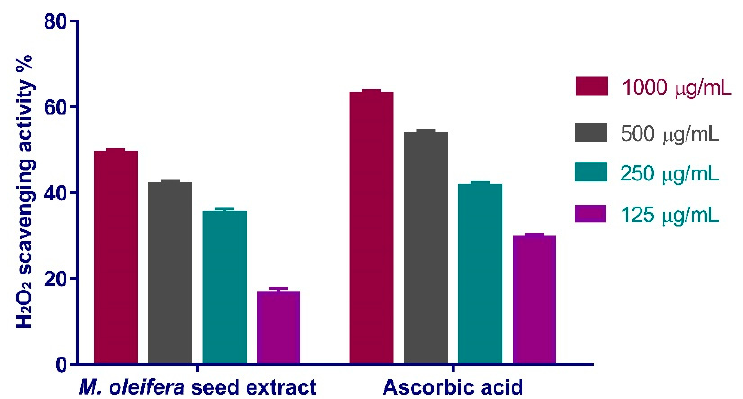
Figure 6. H 2 O 2 radical scavenging activity of M. oleifera seeds extract at different concentrations (1000 µ g/mL, 500 µ g/mL, 250 µ g/mL, and 125 µ g/mL). Bars represent mean ± SD. Significant difference between groups is analyzed by a Two-way ANOVA test.